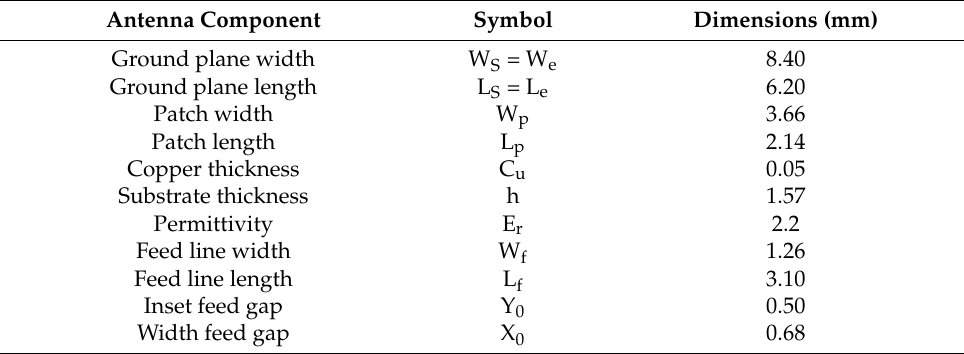
Figure 4. The optimized antenna model view, front and back side with dimensions. Table 2. Dimensions of the optimized antenna